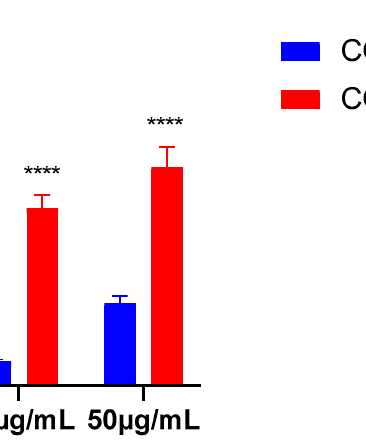
Figure 7. Concentration of the cytokines IL-6 (A), INF-y (B) and IL-10 (C) and TNF-a (D), evaluated by ELISA of the serum of the animals used in the experiments. **, **** Significant differences, at p < 0.005 and 0.0001, respectively, compared to the saline group (CTL − ); (one-way ANOVA; Tukey).